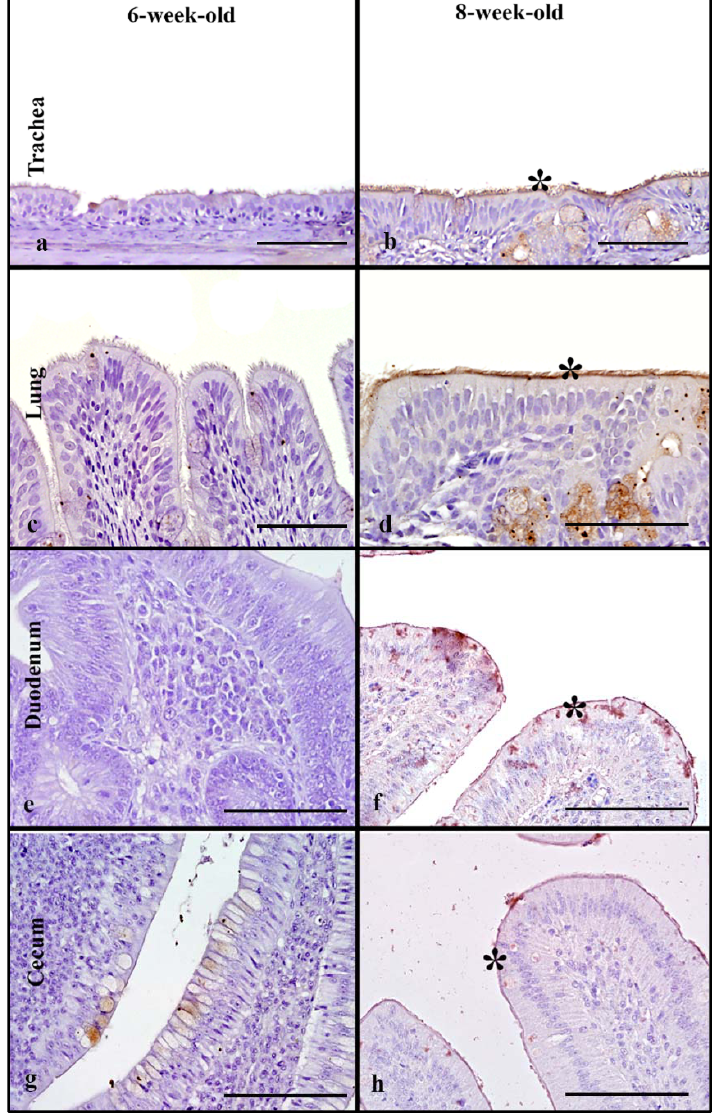
Figure 8. Surface area of LPAIV H5 rHA binding in Turkeys of different age groups, denoted by dark brown staining using DAB- HRP via protein histochemistry denoted by asterisk (*). Note moderate and very strong levels of rHA binding in the trachea and lung of 8-week-old and 6- week-old birds to respiratory epithelial cells ( b , d ). In the lower intestine, rHA binding is mild in both age groups ( e – h ). Scale bar is 50 µm.